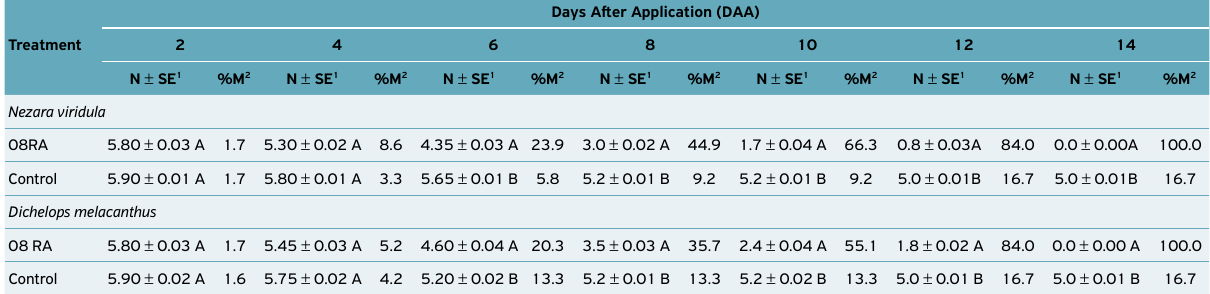
Table 2. Average number of live insects (N ± SE) and accumulated mortality (%M) of N. viridula or D. melacanthus adults exposed to M. anisopliae 08RA isolate under greenhouse conditions.